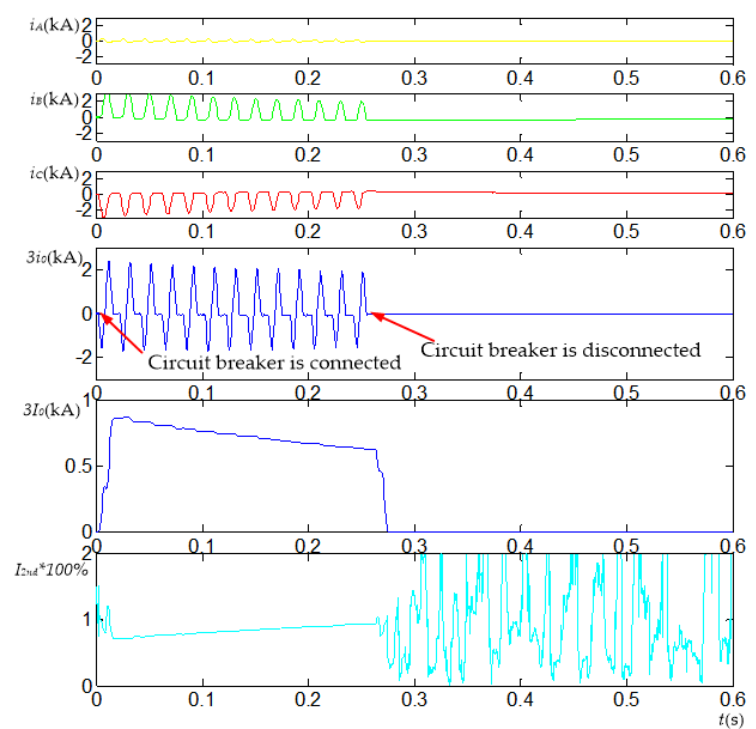
Figure A2. Recorded waveform No. 1 (0–0.6 s).